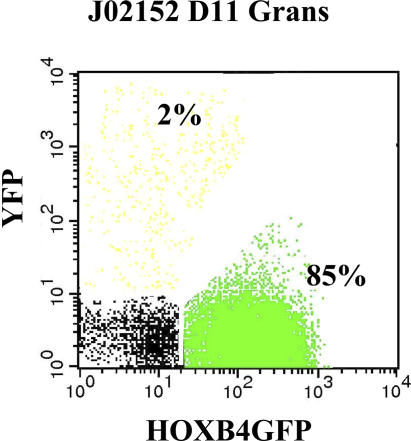
There is a high percentage of HOXB4GFP
+ cells early after transplantation